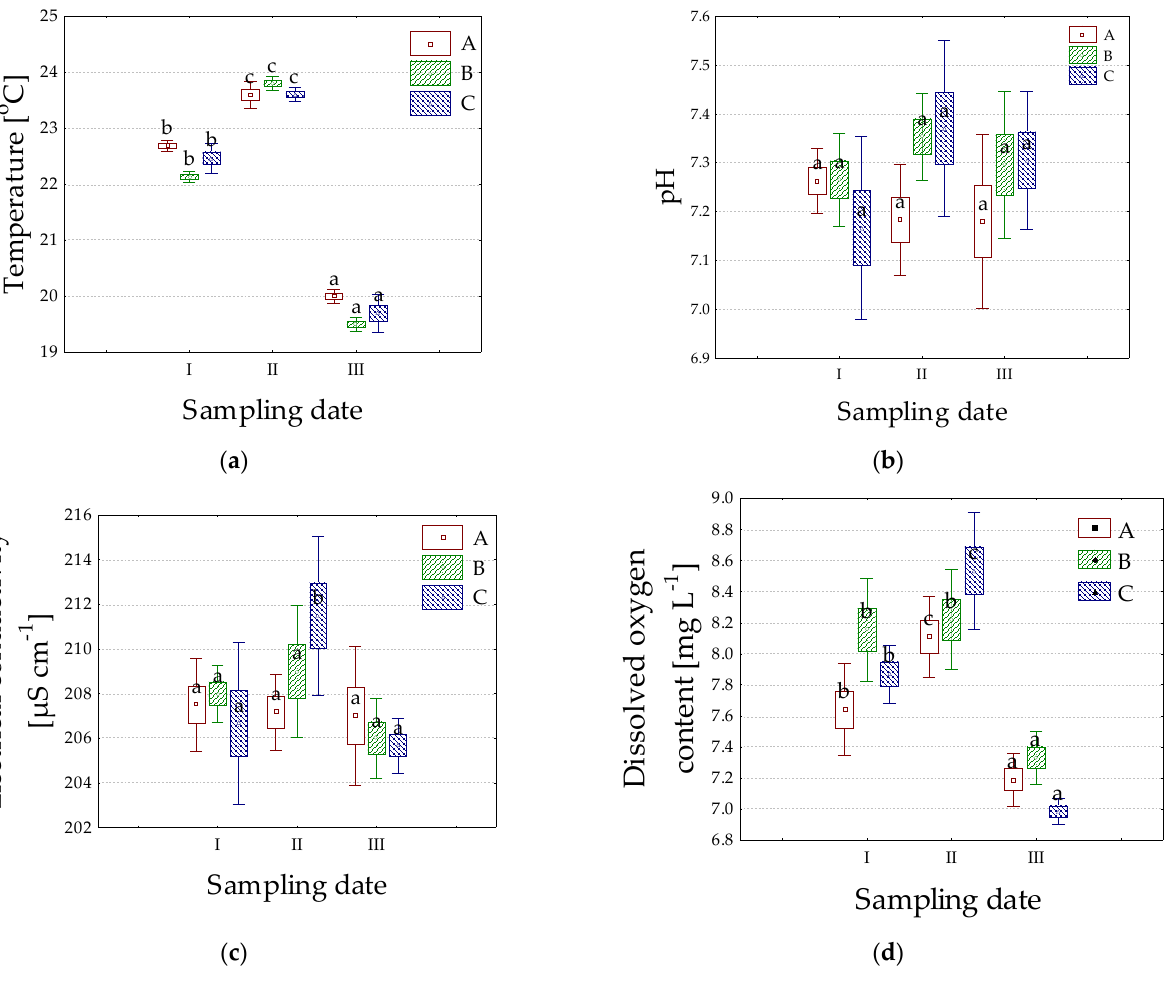
Figure 3. Changes in ( a ) water temperature, ( b ) pH, ( c ) electrical conductivity, and ( d ) dissolved oxygen content, in water samples in successive dates of sampling in three measurement points (A, B, C) Different letters (a, b, c) indicate statistically significant differences among sampling dates.